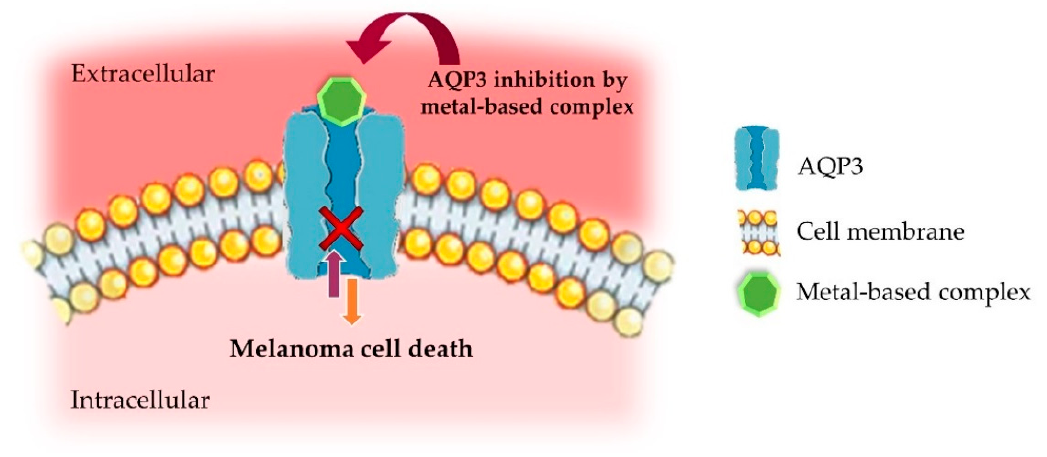
Figure 1. Schematic representation of AQP3 inhibition by metal-based complexes in melanoma cells. Adapted from [28], with permission from Elsevier, 2017.